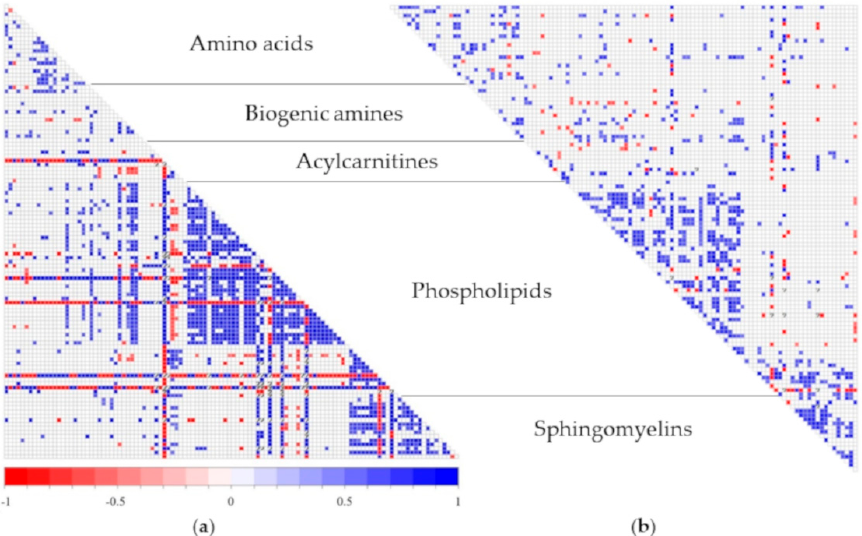
Figure 2. Spearman rank correlation map of milk metabolites in ( a ) BMI > 18.5 mothers and ( b ) stunted infants groups. Only significant correlations are shown ( p < 0.05).